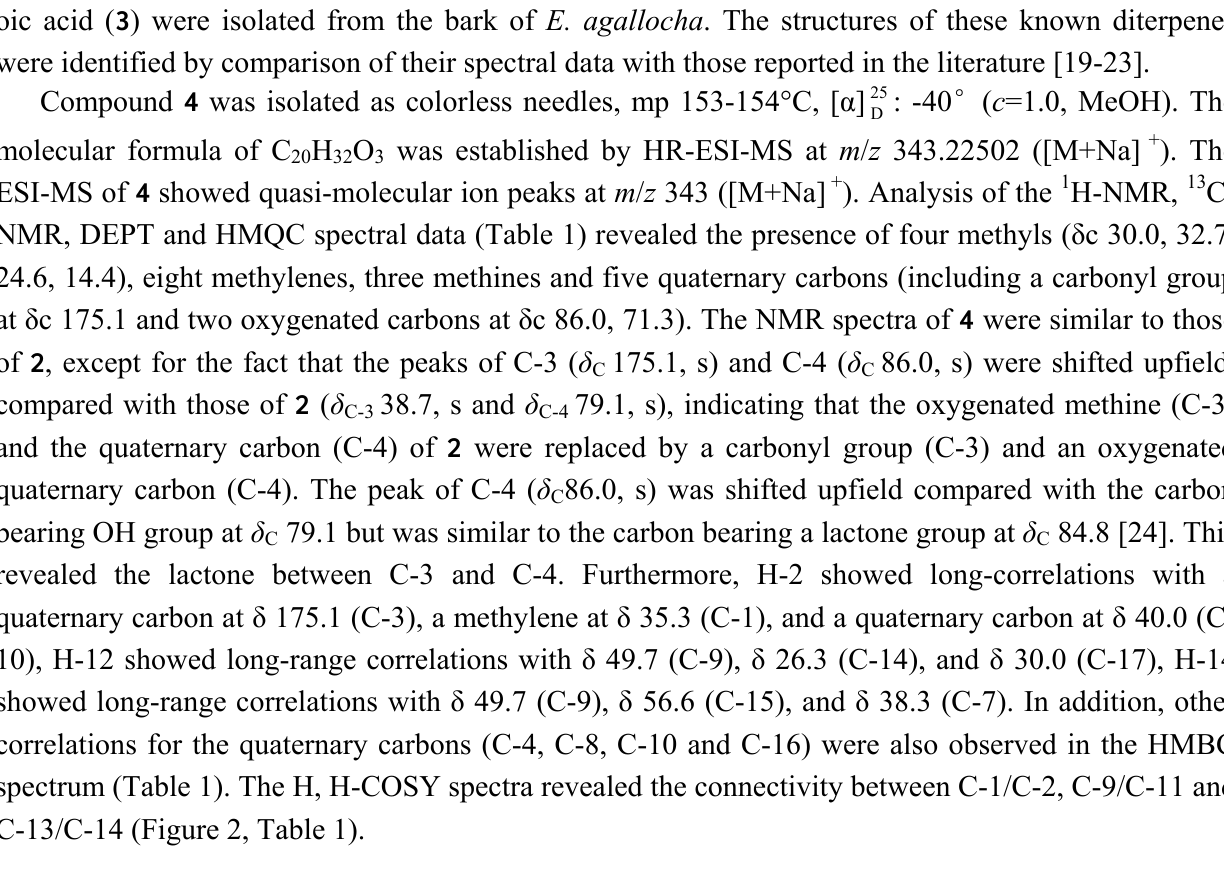
Figure 2. The key H, H-COSY and HMBC correlations of compound 4